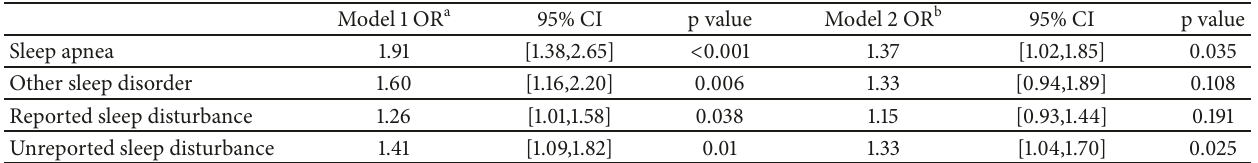
Table 4: Logistic regression predicting odds of RDW ⩾